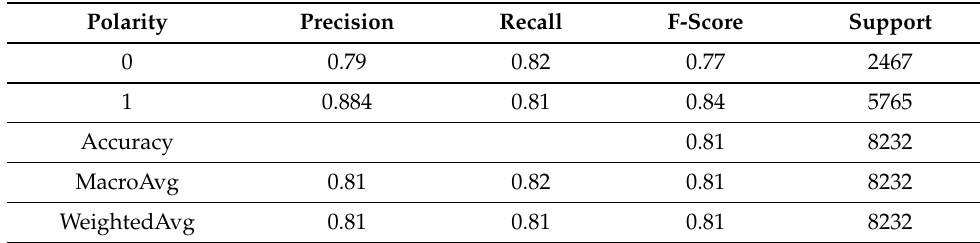
Table 4. Logistic Classifier for multiclass classification. Training accuracy Score: 0.9269020501138952.